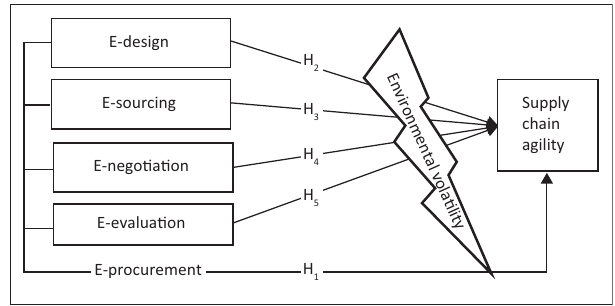
FIGURE 1: The conceptual